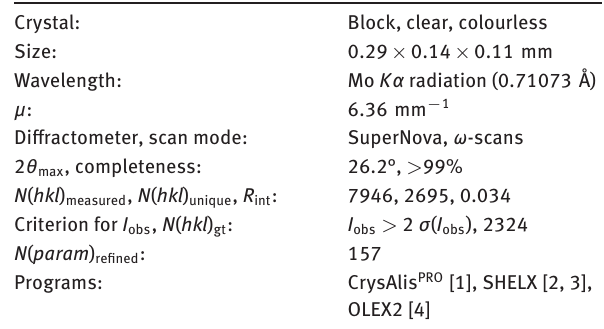
Table 1: Data collection and